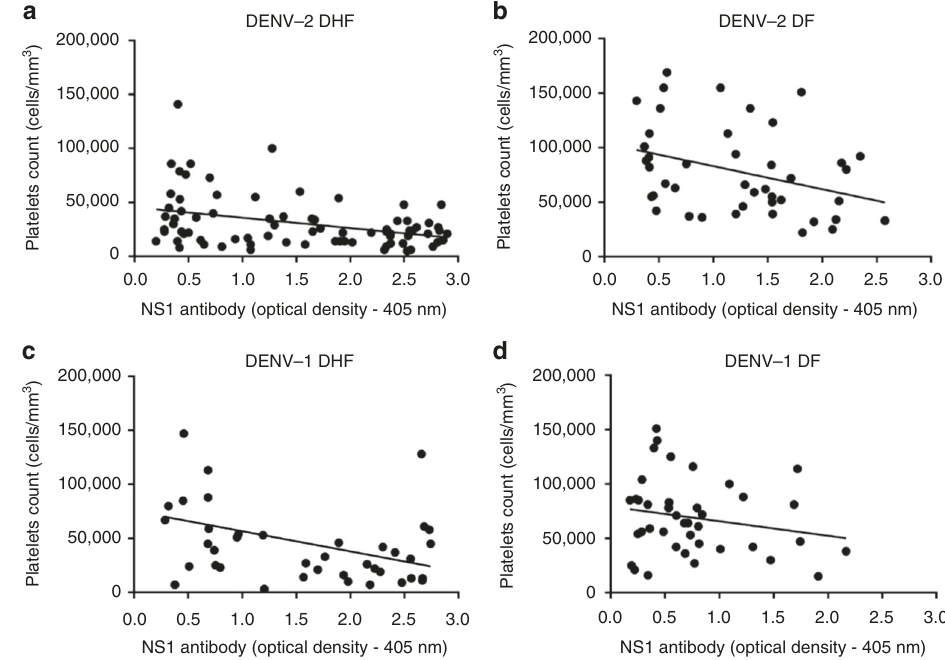
Fig. 2 Correlation of NS1 antibody titres with platelet counts. Correlation of NS1 antibody titres in patients with acute secondary DENV1 and DENV2 infection with platelet counts. Serum anti-NS1 antibody titres were measured throughout the course of illness by ELISA and correlated with circulating platelet counts in patients with ( a ) DHF due to DENV2, n = 23 (Spearmans ’ r = − 0.3, p = 0.008), ( b ) DF due to DENV2, n = 12 (Spearman ’ s r = − 0.39, p = 0.009), ( c ) DHF due to DENV1, n = 10 (Spearman ’ s r = − 0.3, p = 0.03), and ( d ) DF due to DENV1, n = 10 (Spearman ’ s r = − 0.17, p =